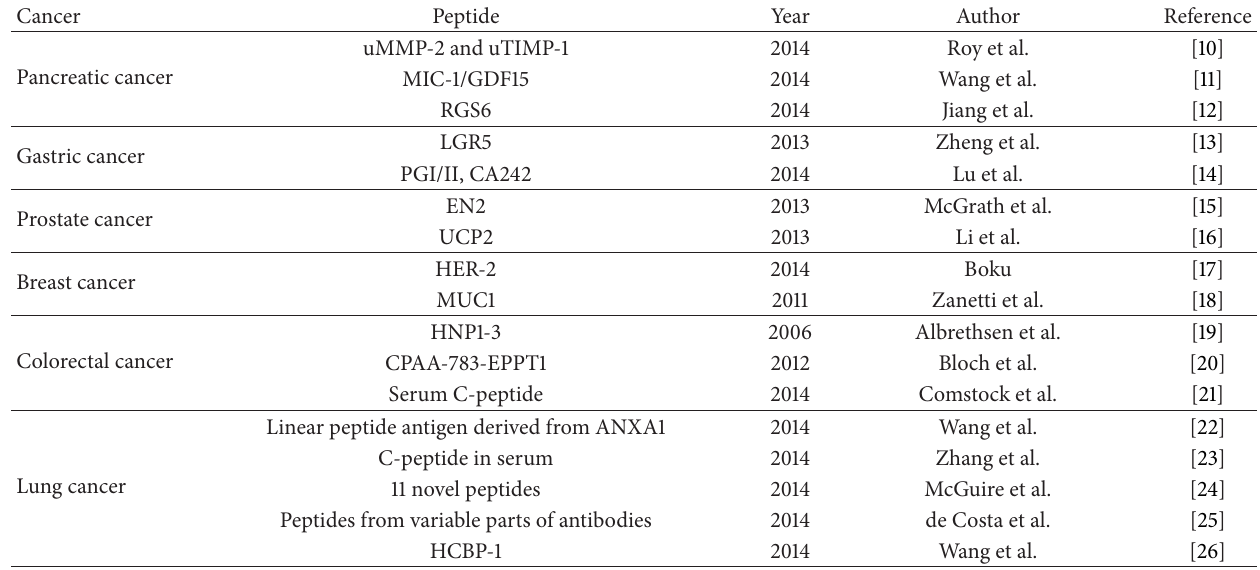
Table 1: Peptides applied in cancer